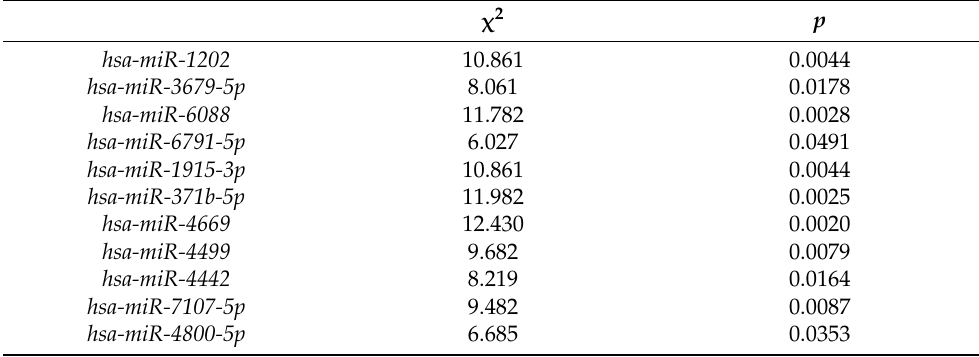
Table 3. The Table reports results of Kruskal–Wallis rank test considering lymph node metastases as variable defining groups and any individual miRNA as predictor